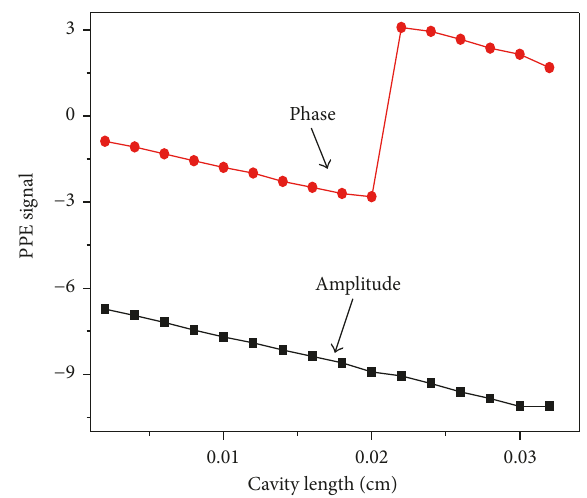
Figure 2: Phase (radian) and logarithm of amplitude of the PE signal as a function of the cavity length. The jump in-phase shows a discontinuity between −𝜋 and 𝜋 .